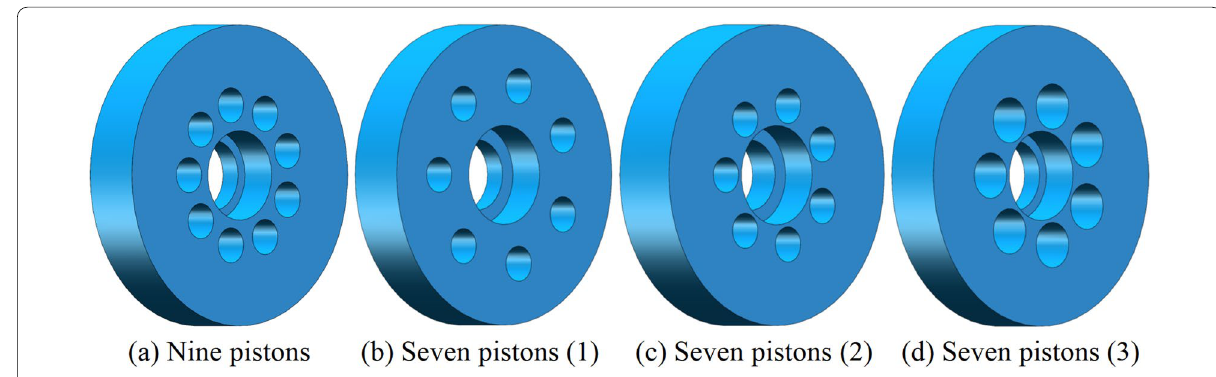
Figure 14 Three-dimensional model of the fluid zone